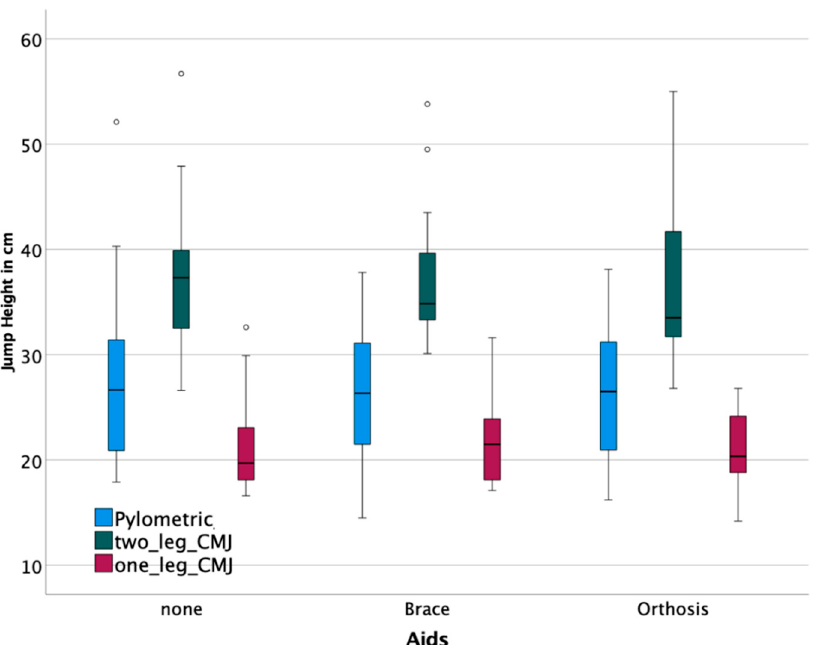
Figure 5. Jump tests show no clinically relevant difference between devices. (° are outliers).